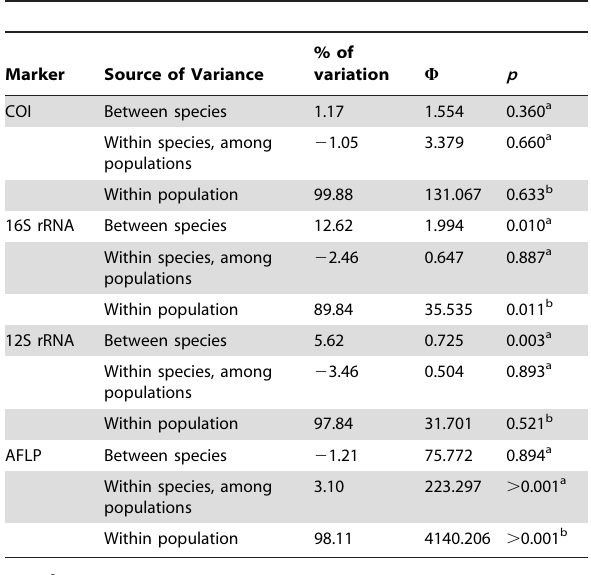
Table 3. Global locus-by-locus analyses of molecular variance (AMOVA) results as weighted averages over